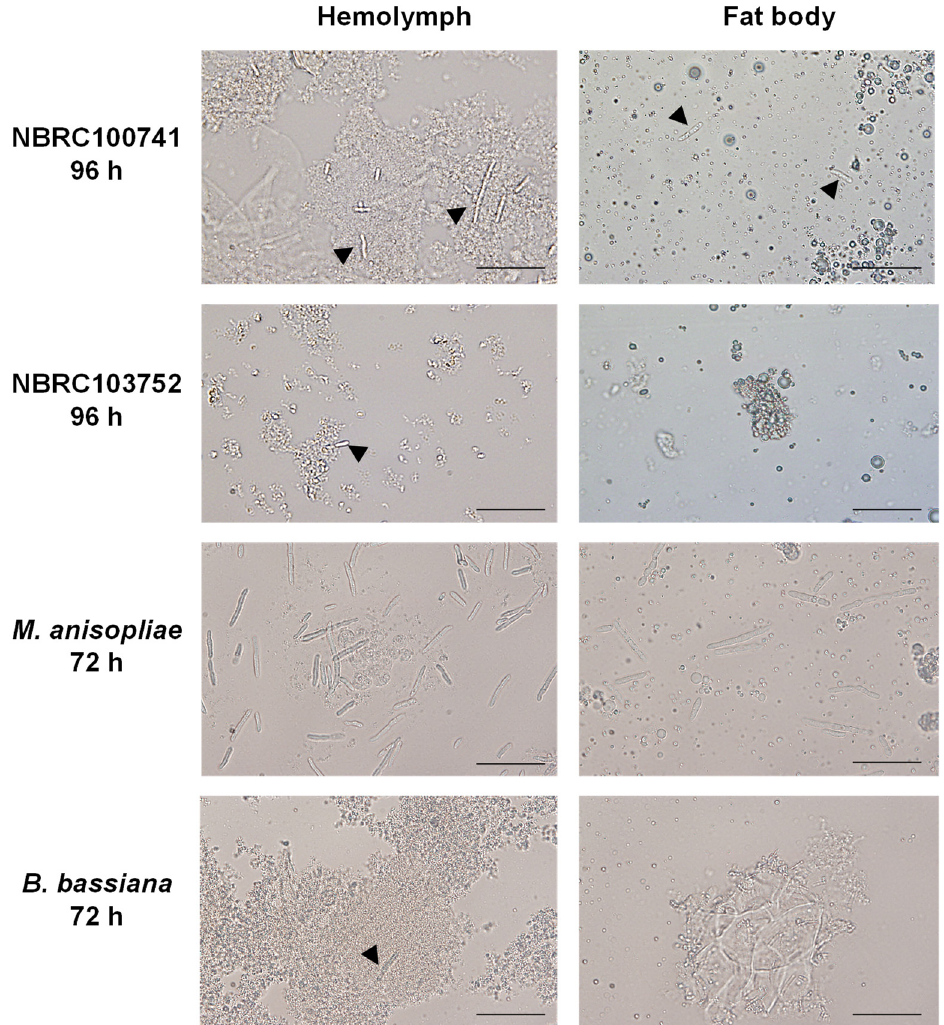
Figure 2. Growth of each entomopathogenic fungi in silkworm larvae. Hemolymph and fat bodies were collected daily after conidia injection and mycelia were observed microscopically. NBRC100741 and NBRC103752 indicate C. militaris NBRC100741 and NBRC103752 strains, respectively. Black bars indicate 50 μ m. Arrow heads indicate hyphal bodies.